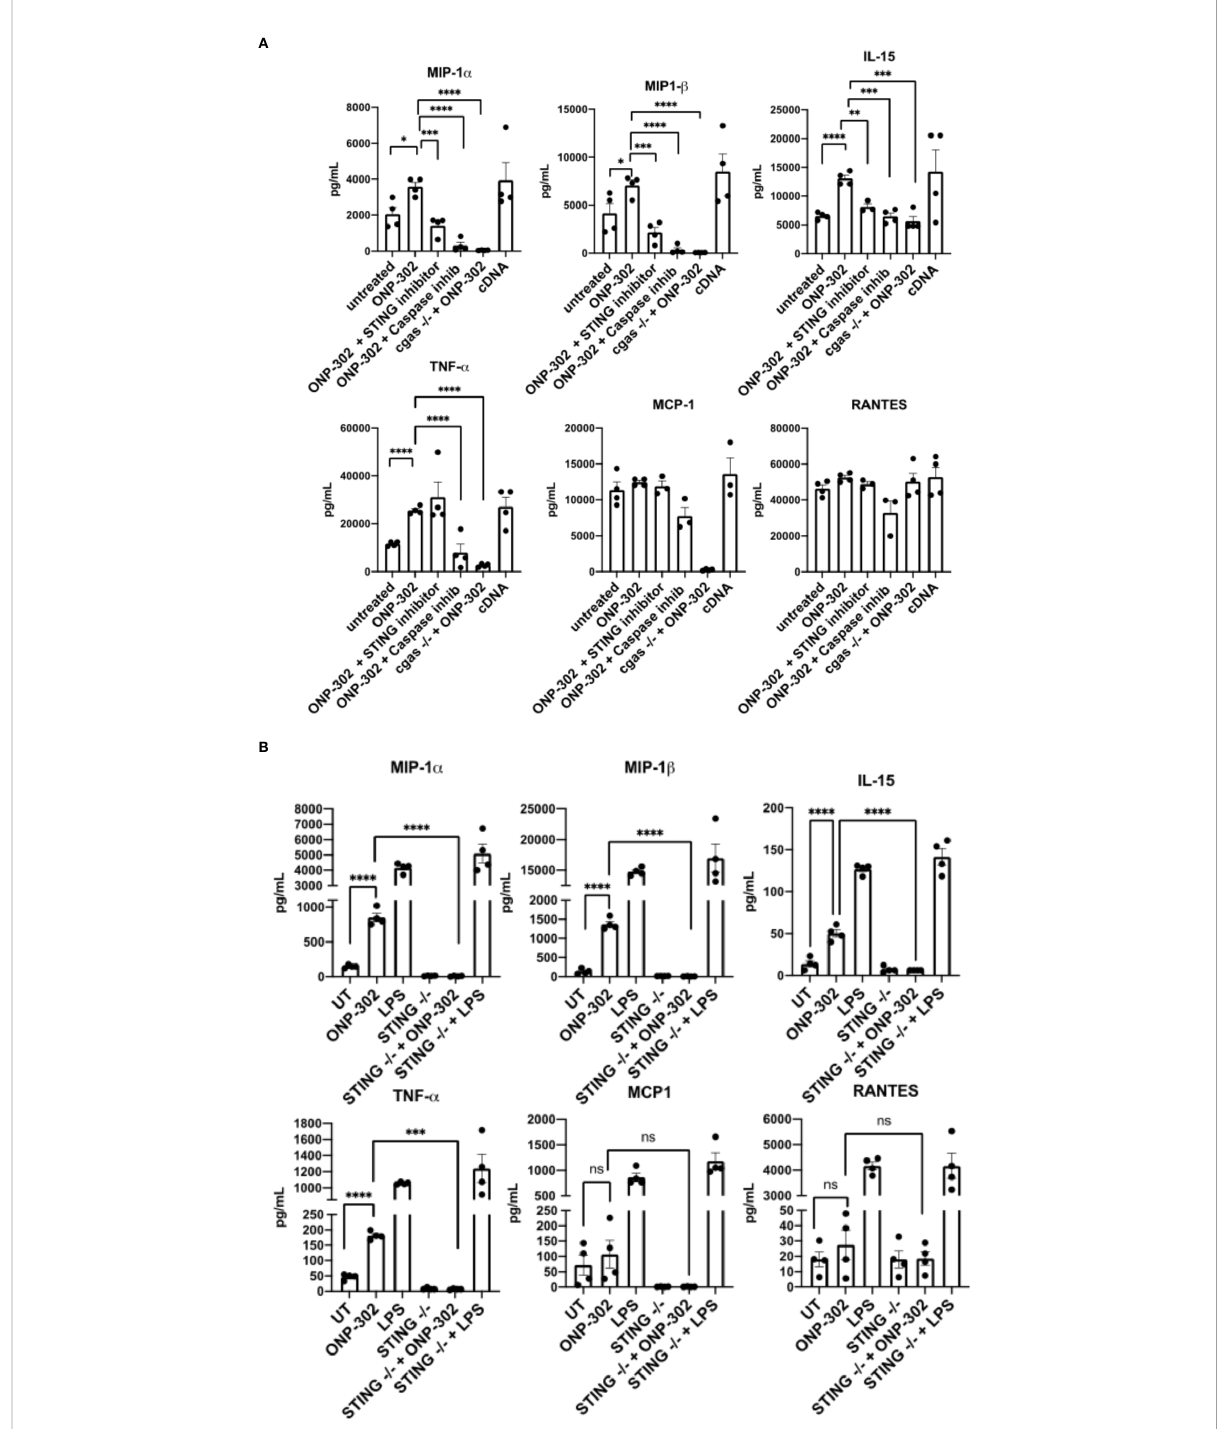
FIGURE 3 Uptake of ONP-302 by RAW cells (A) and bone marrow-derived macrophages (BMDM) (B) induces cytokine production via the cGAS/ STING pathway. RAW cells possessing or lacking the cGAS gene (cGAS -/-) were treated with ONP-302 for 24 hours in the presence or absence of a STING inhibitor (RU.521) or a Caspase inhibitor (ZVAD-FMK) and supernatants were collected to measure the level of chemokines and cytokines. BMDMs from either wt C57BL/6 mice or STING -/- mice were treated with ONP-302 for 24 hours and supernatants were collected to measure the level of chemokines and cytokines. Each dot represents a unique well of cells tested and the bar represents the mean ± S.E.M. Asterisks (*, **, ***, ****) indicate a statistically signi fi cant difference as compared to untreated cells, p < 0.05, < 0.01, < 0.001, and < 0.0001 respectively. NS, not signi fi